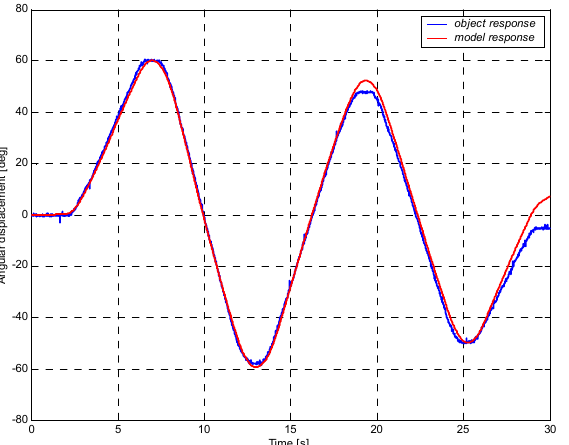
Figure 12. Comparison of the response of model and real object of DC motor with a gearbox.